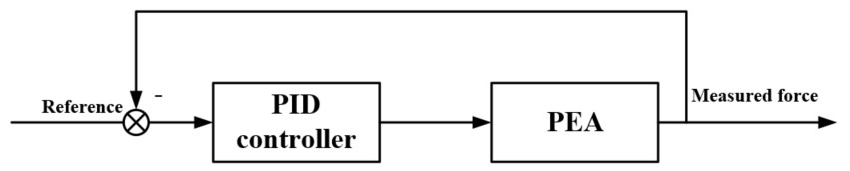
Figure 9. Block diagram of the PID controller.